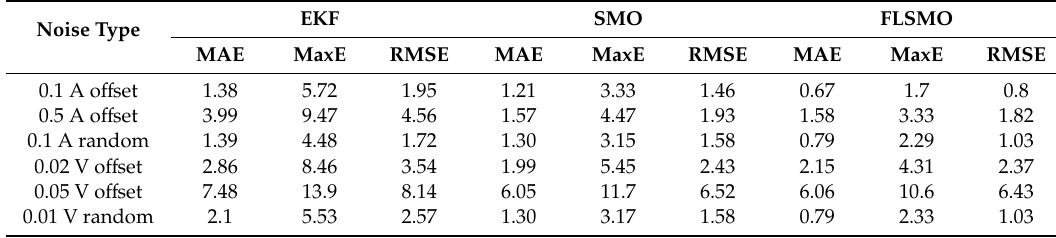
Figure 9. SOC estimation error under di ff erent noise type: ( a ) 0.1 A current o ff set; ( b ) 0.5 A current o ff set; ( c ) 0.1 A current random; ( d ) 0.02 V voltage o ff set; ( e ) 0.05 V voltage o ff set; ( f ) 0.01 V voltage random.